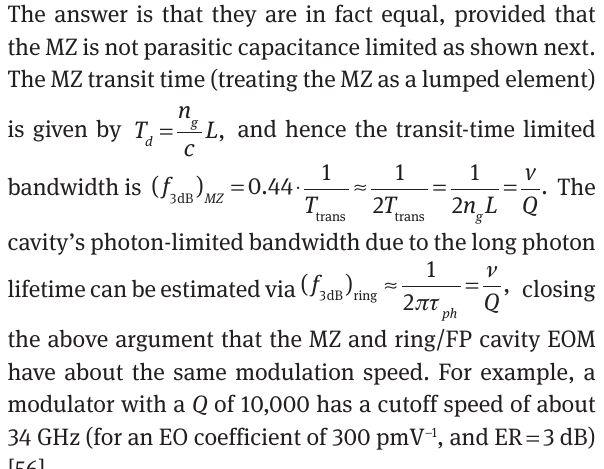
= group index, λ = g